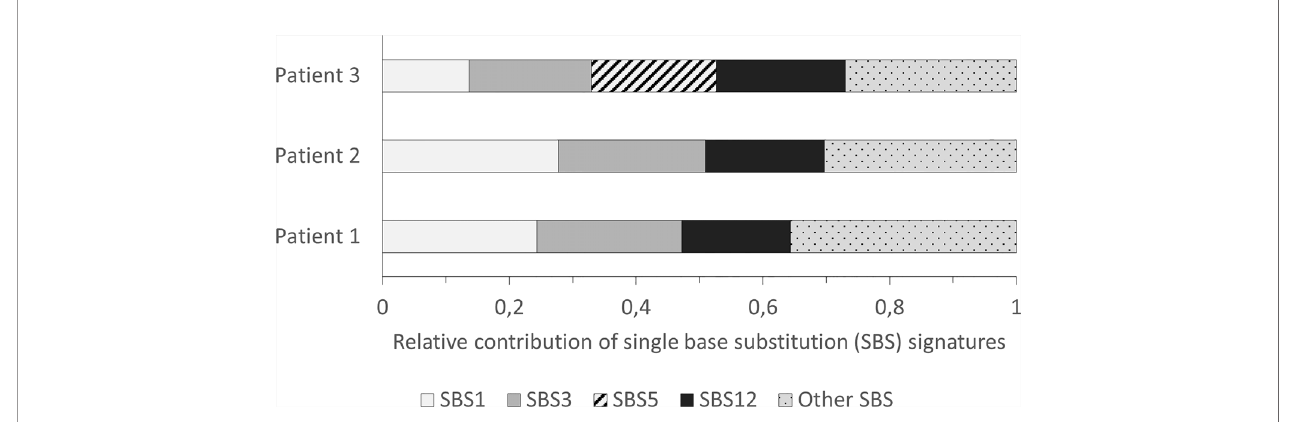
FIGURE 1 | Single base substitution (SBS) signatures identi fi ed in the patients with a relative contribution ≥ 15% of the